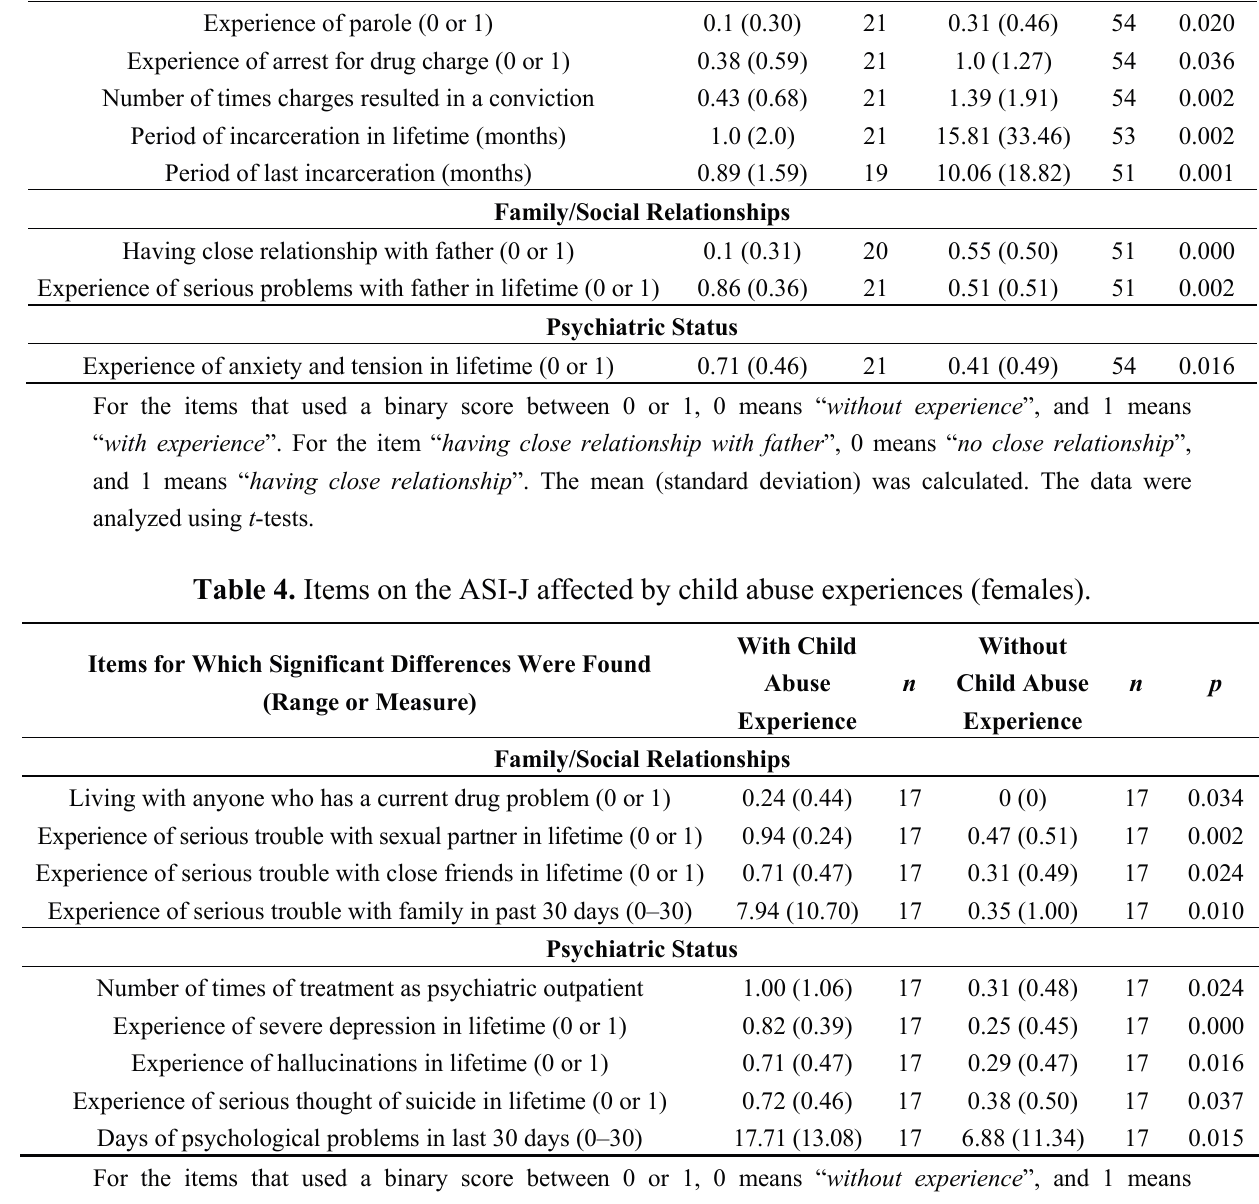
Table 3. Items on the ASI-J that are affected by child abuse experiences (males). Items for Which Significant Differences Were Found (Range or Measure)